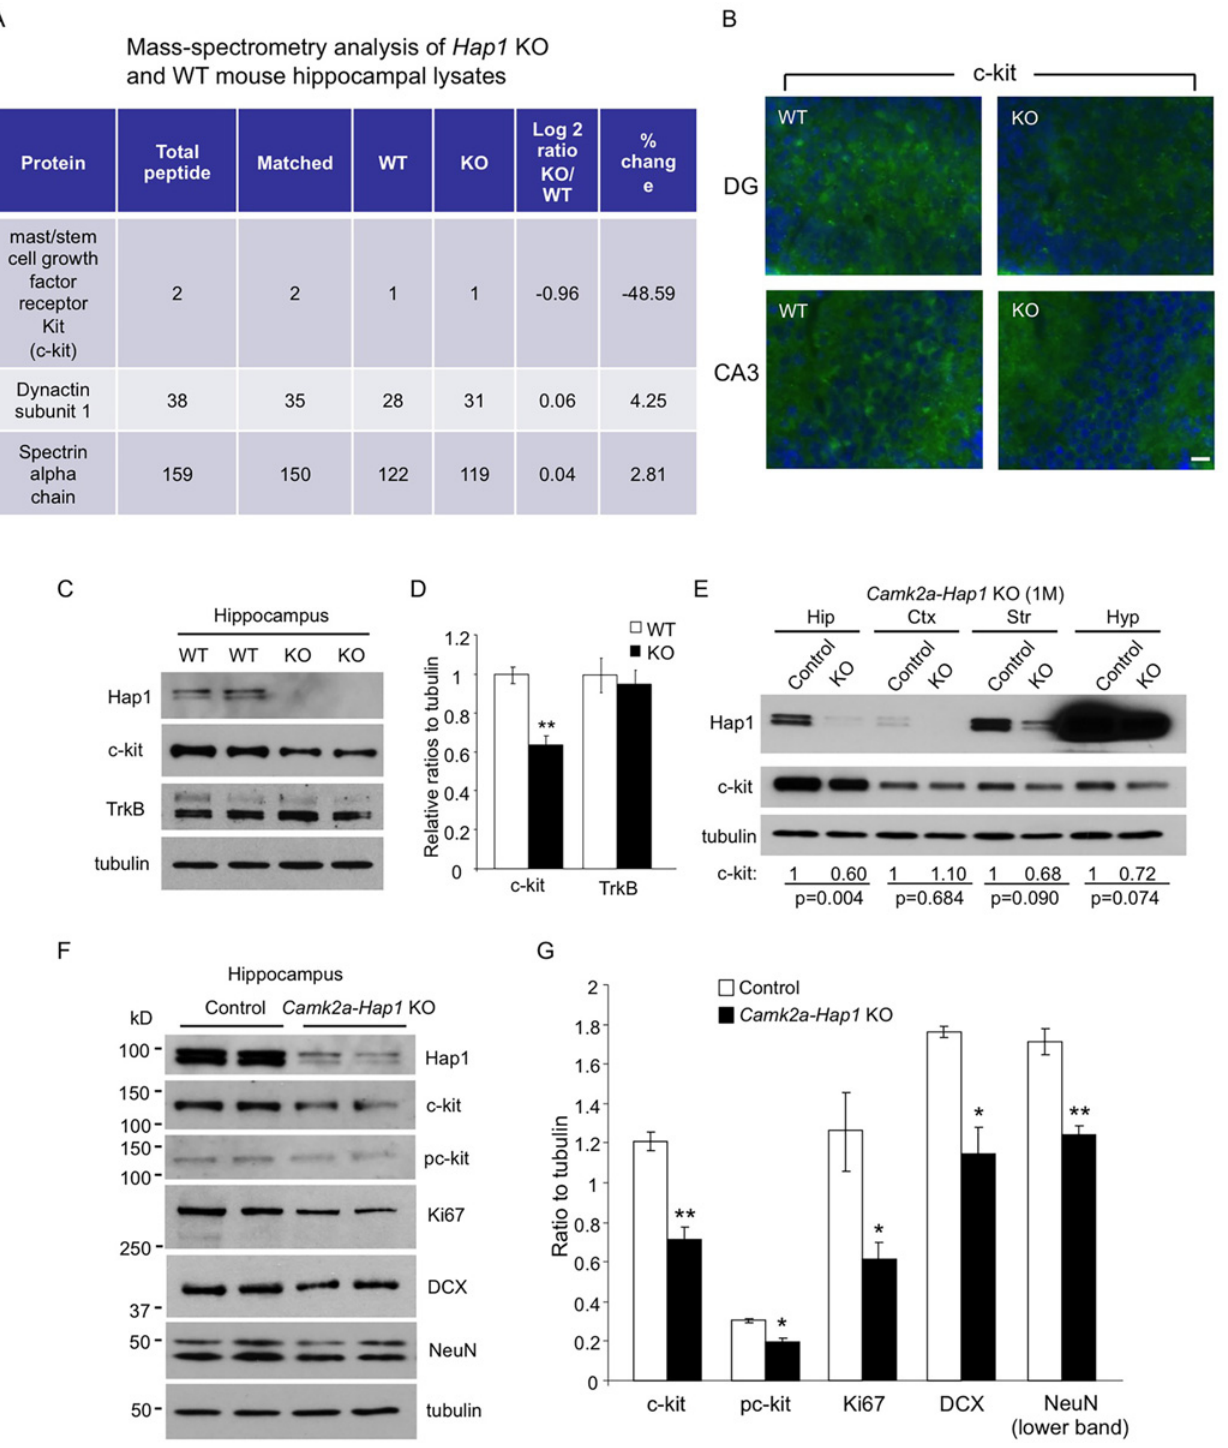
Fig 5. c-kit expression level is reduced in Hap1 KO hippocampus. ( A ) Mass spectrometry analysis of P1 WT and Hap1 KO mouse hippocampal lysates revealing reduced c-kit expression level in Hap1 KO hippocampus. Log2 ratios were calculated based on the extracted ion current of the peptide signals from the chromatogram. ( B ) Immunofluorescent staining of c-kit on P1 WT and Hap1 KO mouse brain sections showed decreased c-kit level in Hap1 KO hippocampus. Scale bar: 10 μ m. ( C ) Western blot analysis on WT and Hap1 KO hippocampal lysates also confirmed the decreased c-kit protein level in KO samples. The level of TrkB, however, was not decreased. ( D ) Quantification of relative ratios of c-kit and TrkB normalized to WT is shown. n = 4 per